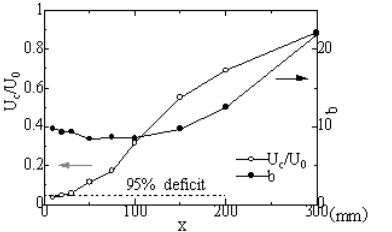
Fig. 9 Downstream variation of wake half-width and center line velocity (14Hz